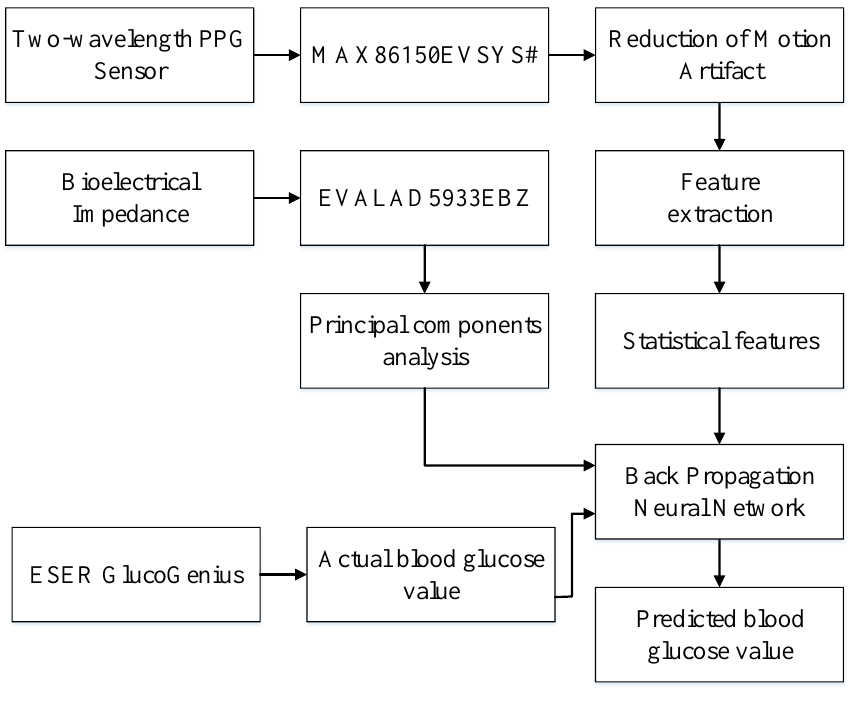
Figure 4. Experimental system